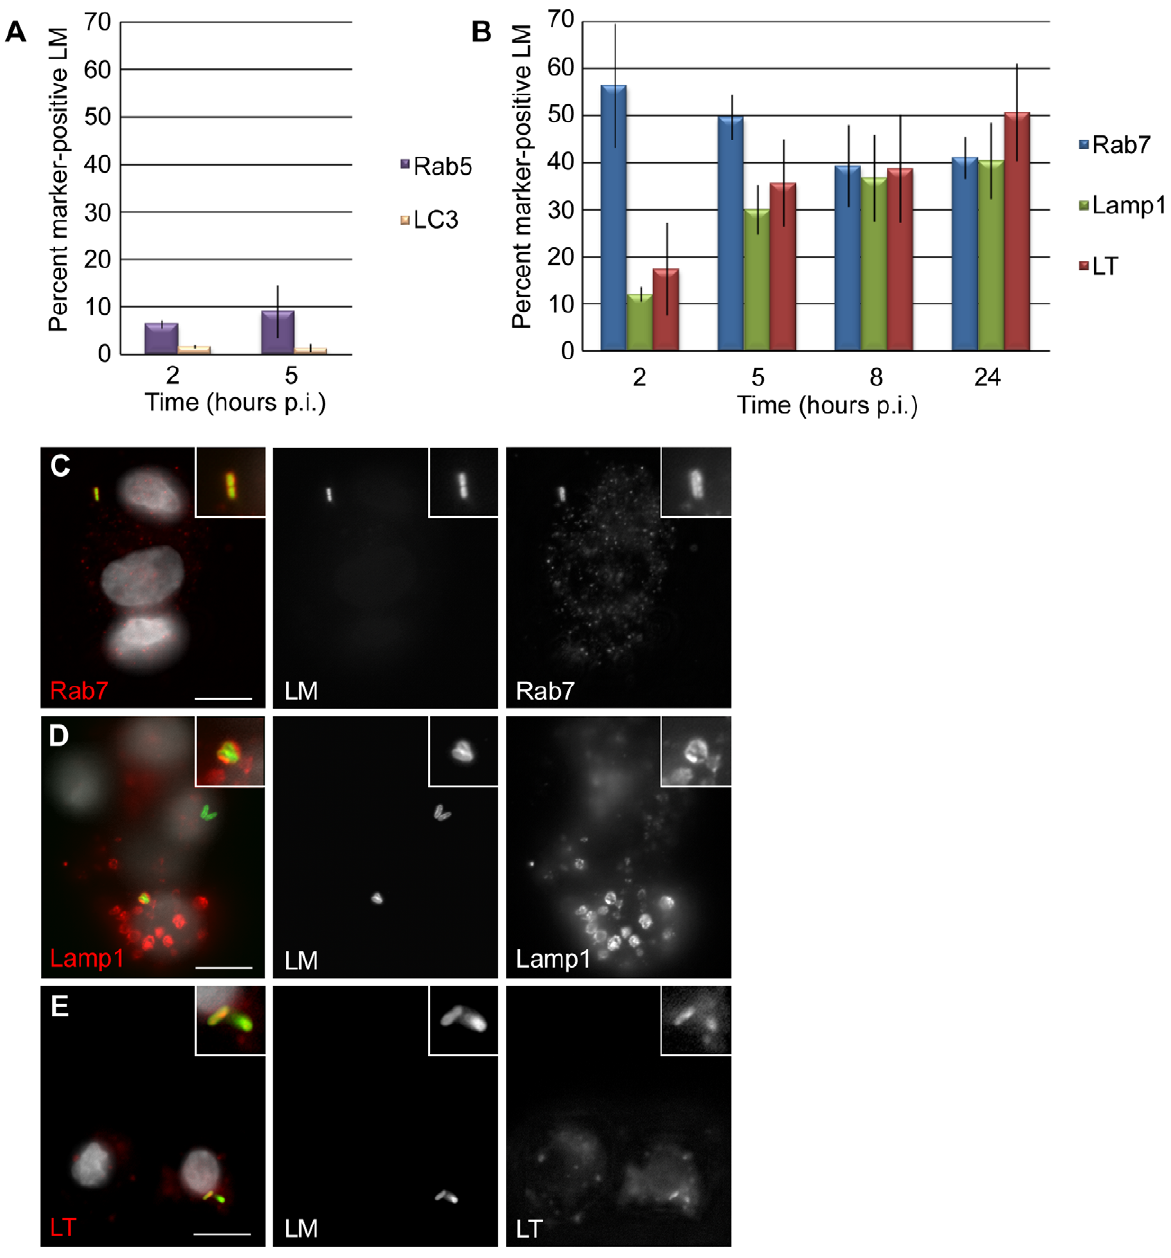
Figure 4. L.monocytogenes (LM) is trapped in late endosomes and acidified lysosomes in EVT. ( A ) Percent co-localization of early endosomal marker Rab5 and autophagosomal marker LC3 with LM. ( B ) Percent co-localization of late endosomal marker Rab7, lysosomal marker Lamp1 and acidotropic dye Lysotracker (LT) with LM. p.i. = post-inoculation. Each data point is an average of 3 independent experiments. Bars represent SEM. ( C–E ) Representative images of GFP-expressing LM (green) co-localizing with markers Rab7, Lamp1, and LT (red). The color-merged images also show DAPI counterstain (white). Scale bars are 10 m m.